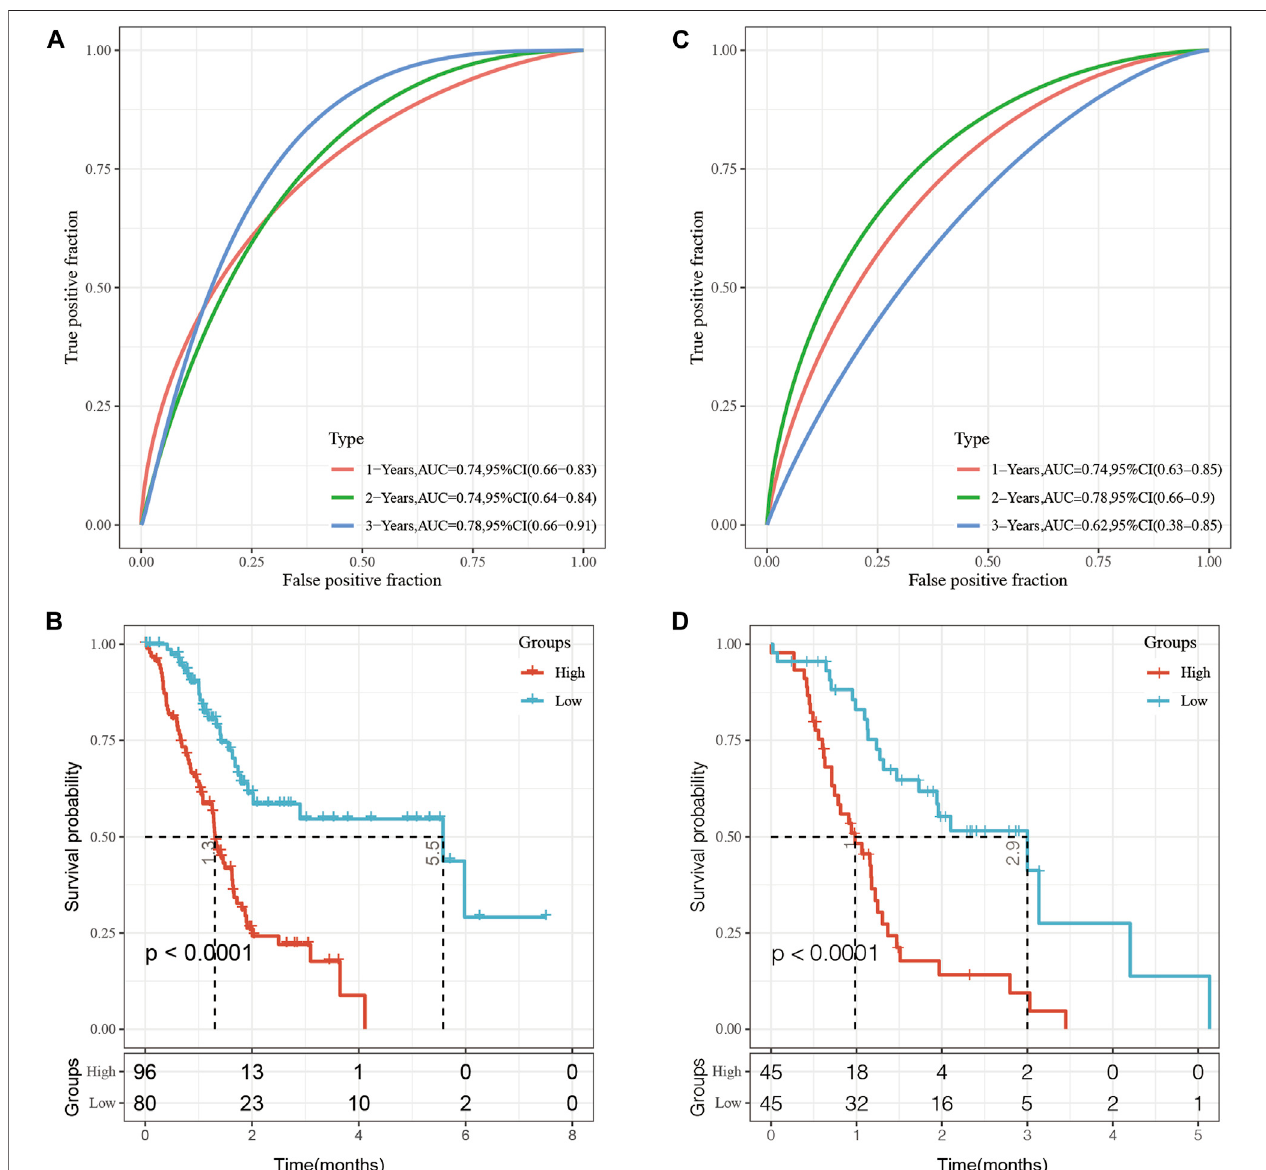
FIGURE7|(A) ROCanalysisof fi ve-epi-lncRNAscoresinTCGAdataset; (B) Prognosticdifferencesbetweenpatientsinhigh-andlow- fi ve-epi-lncRNAsubgroups in the TCGA dataset; (C) ROC analysis of fi ve-epi-lncRNA scores in ICGC-AU dataset; (D) Prognostic differences between patients in high- and low- fi ve-epi-lncRNA subgroups in the ICGC